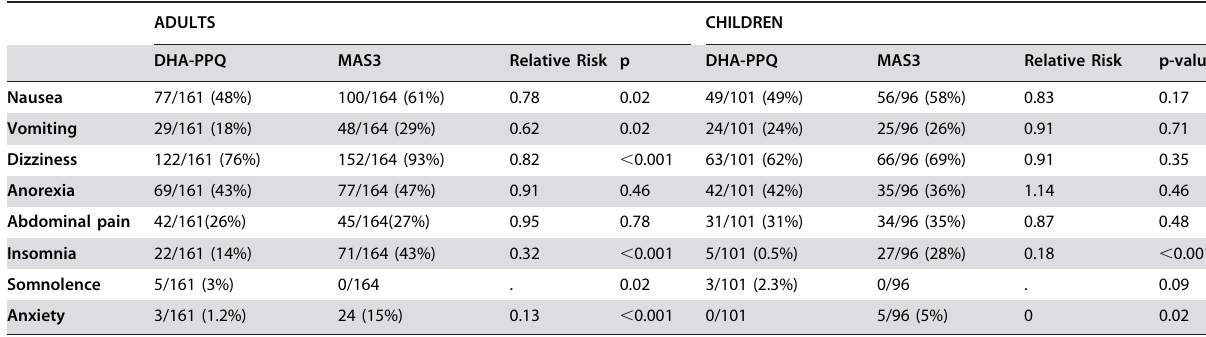
Table 4. Adverse events by age and treatment group within the first week of follow up. .. ... .... ... ... .... ... ... .... ... ... .... ... ... .... ... ... .... ... ... .... ... ... .... ... ... .... ... ... .... ... ... .... ... ... .... ... ... .... ... ... .... ... ... . ADULTS